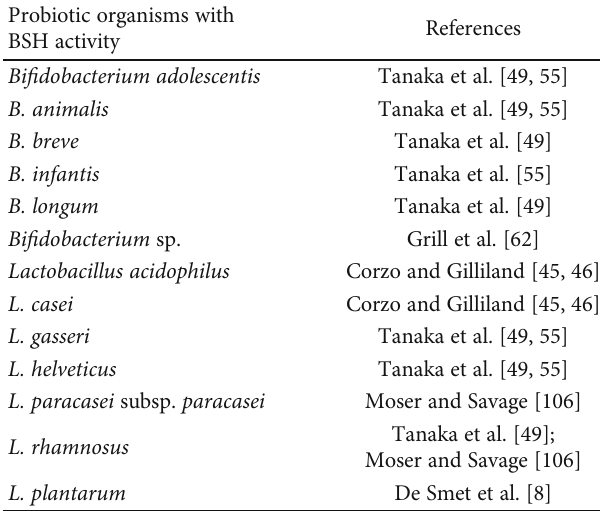
Table 1: List of some potential bacteria showing BSH